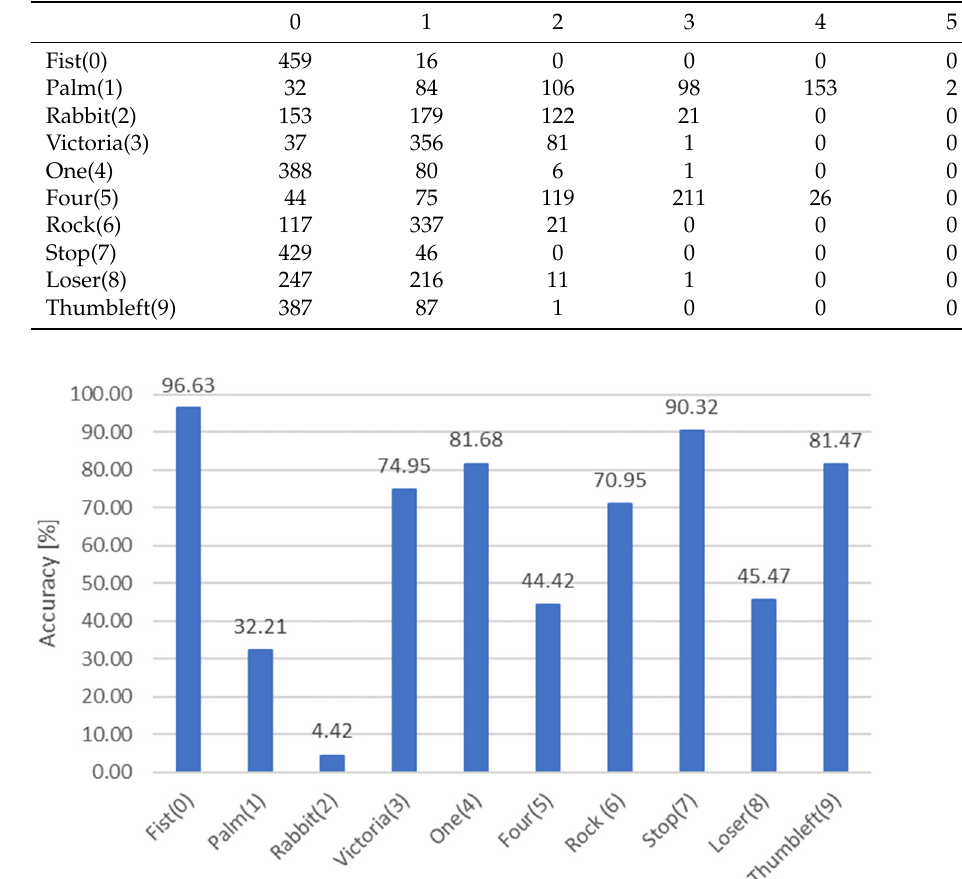
Figure 8. Accuracy for all the gesture’s classes.